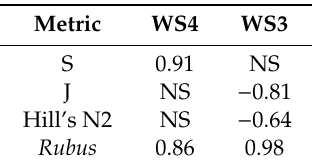
Table 1. Pearson product–moment correlation coe ffi cients between species richness (S), evenness (J), and diversity (Hill’s N2), and cover of Rubus allegheniensis ( Rubus , in %) versus time (years) on reference WS4 and treatment WS3. Thus, significant positive and negative coe ffi cients indicate increases and decreases, respectively, over time. Values shown are coe ffi cients significant at p < 0.05. NS indicates no significant